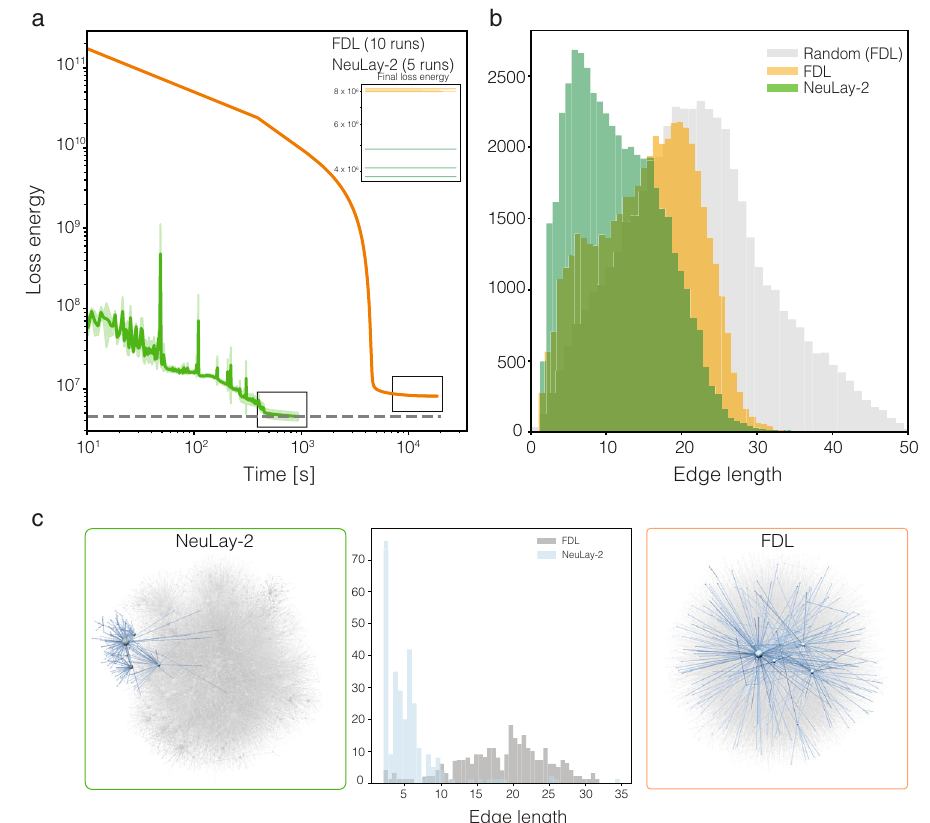
Fig. 3 | The interpretability of the layout. The Internet, with 22,963 nodes, and 48,436 links is large enough to represent a dif fi cult visualization task for the existing algorithms. a The time-energy plot shows that NeuLay-2 converges faster and fi nds a considerably lower energy state. NeuLay-2 reparameterizes node positions from the initial iteration, resulting in a signi fi cant decrease in the loss- energy.Indeed,FDLgetstrappedinahigherenergystateandisunabletoreachthe NeuLay-2energylevelevenafteramuchlongertime.Thecurvescorrespondtoten independentruns,thatconvergetoslightlydifferent fi nalenergies,asshowninthe